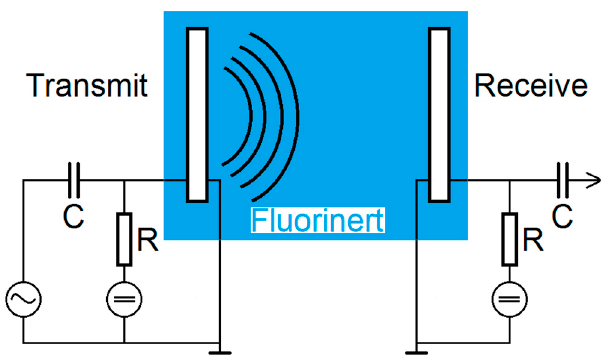
Figure 5. Schematic sketch of the setup for the transmit experiments.